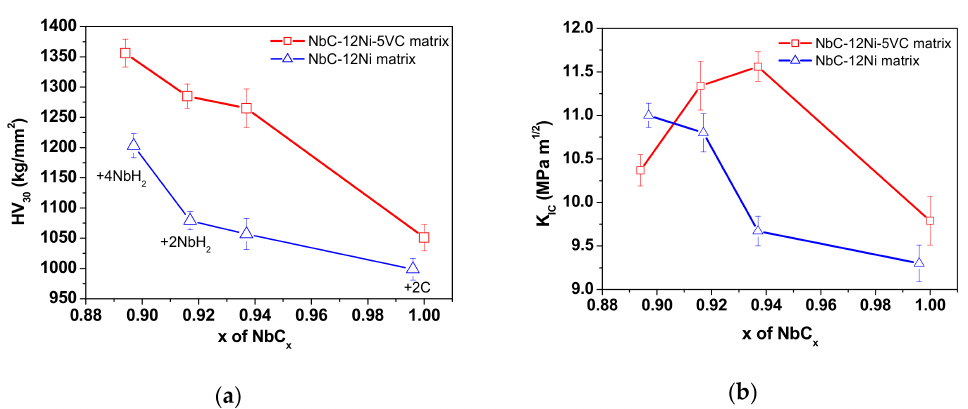
Figure 7. Mechanical properties of the NbC-12 vol % Ni and NbC-5 vol % VC-12 vol % Ni based cermets, ( a ) Vickers hardness (HV 30 ) and ( b ) Indentation fracture toughness (K IC